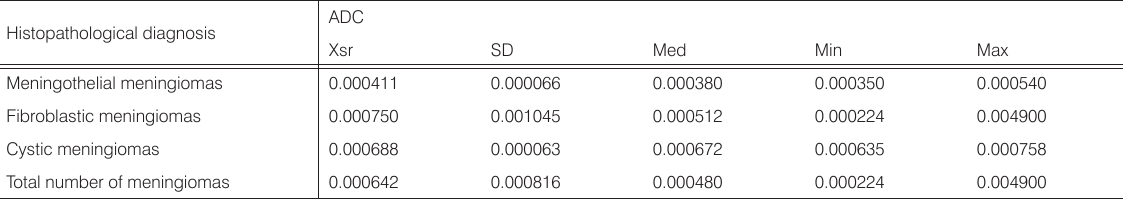
Table 3. The value of ADC (mm 2 /s) of the solid part of meningeoma in comparison with histopathological diagnosis.